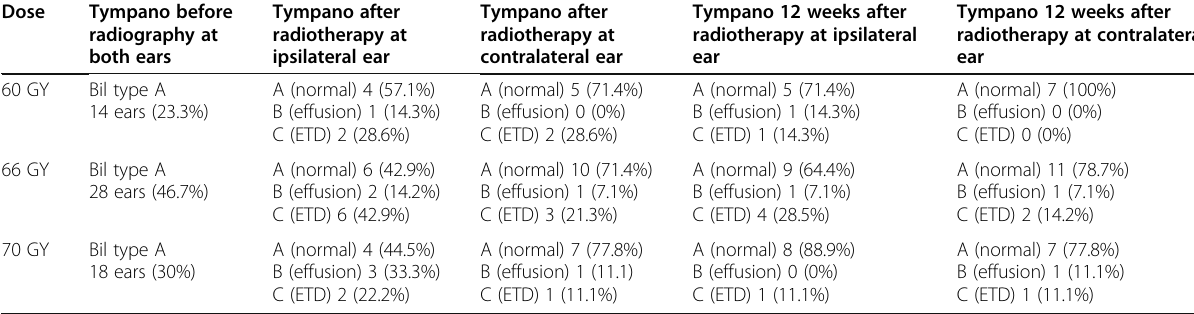
Table 4 Eustachian tube functions according to dose of radiotherapy Dose Tympano before radiography at both ears